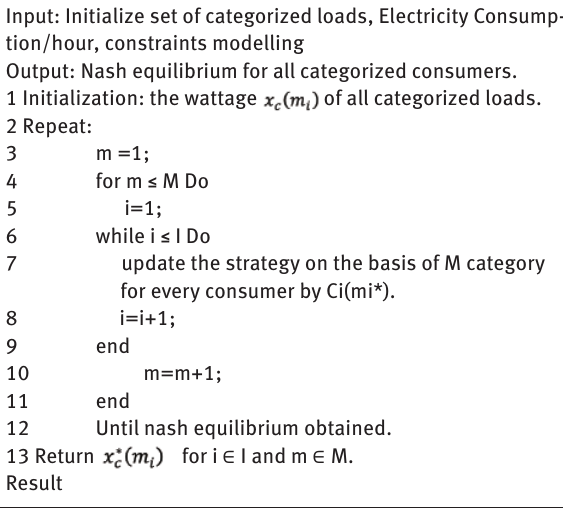
Table 1: Comparative study of normal and peak hour energy tariff